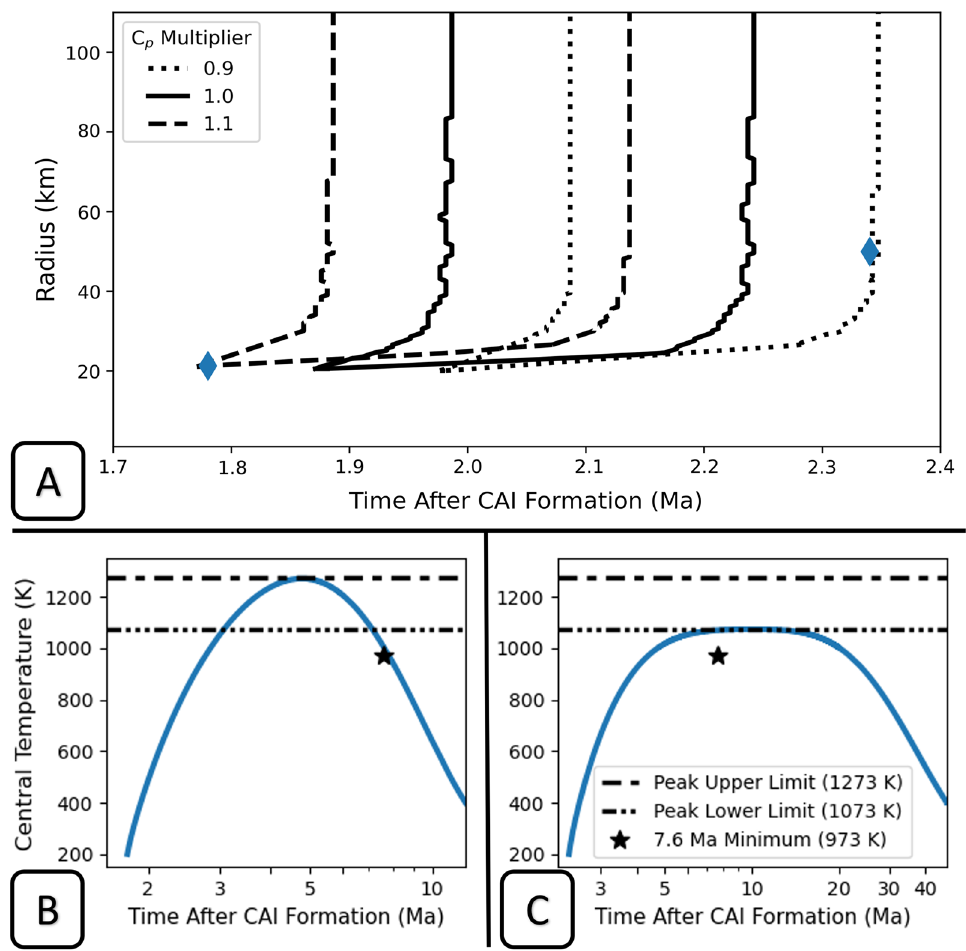
Fig. 2 Effects of varying specific heat capacity. a The effect of uncertainty in specific heat capacity on the range of possible asteroid radii and formation times for an Itokawa-like parent body. Each of the three curves shown is actually made up of three isothermal lines corresponding to Itokawa’s thermal constraints of having a peak temperature between 1073 and 1273 K and a central temperature greater than 973 K at 7.6 Ma, as in Figure 1. The solid black curve shows the original result, seen in Fig. 1. The dashed and dotted curves show the result when the specific heat capacity is increased or decreased, respectively. b , c Central temperature over time for two simulated bodies with end-member specific heat capacity values and formation time and radius values corresponding to the diamond markers on a . b A 21-km radius body formed at 1.78 Ma is able to narrowly avoid exceeding the maximum peak temperature constraint due to its greater heat capacity at 1.1 times the base value. c A 50-km body formed at 2.34 Ma scarcely fulfills the minimum peak temperature constraint due to its lower heat capacity at 0.9 times the base